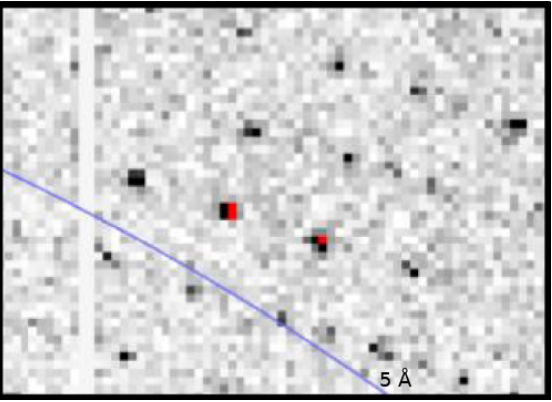
Figure 9. Zoomed lysozyme diffraction pattern recorded on the AGIPD-1M detector. Gray-scale pixel intensity is measured in the “high” gain stage. Pixels colored red have been measured in the “medium” gain stage. Figure modified from original publication in Nat. Commun.